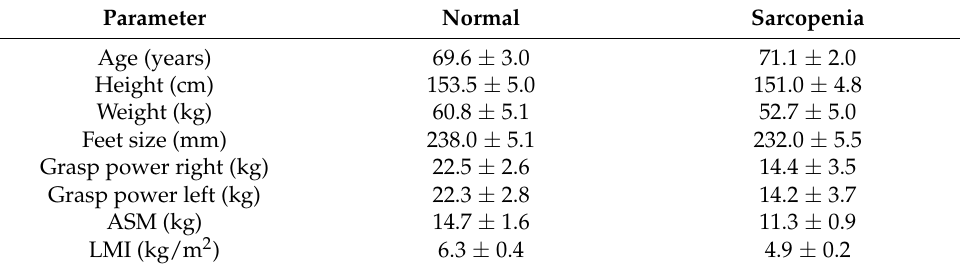
Table 3. Population statistics for normal and sarcopenia